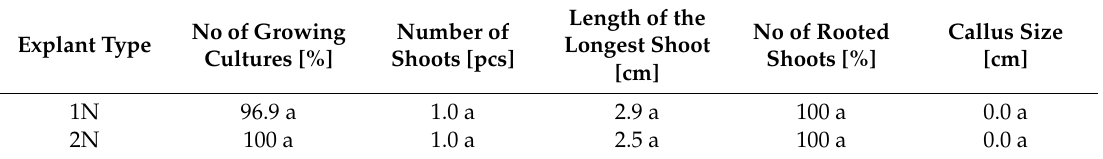
Table 6. Growth of mountain mulberry ‘Kenmochi’ in vitro cultures established from one- (1N) and two-node (2N) explants on “SNC” medium.